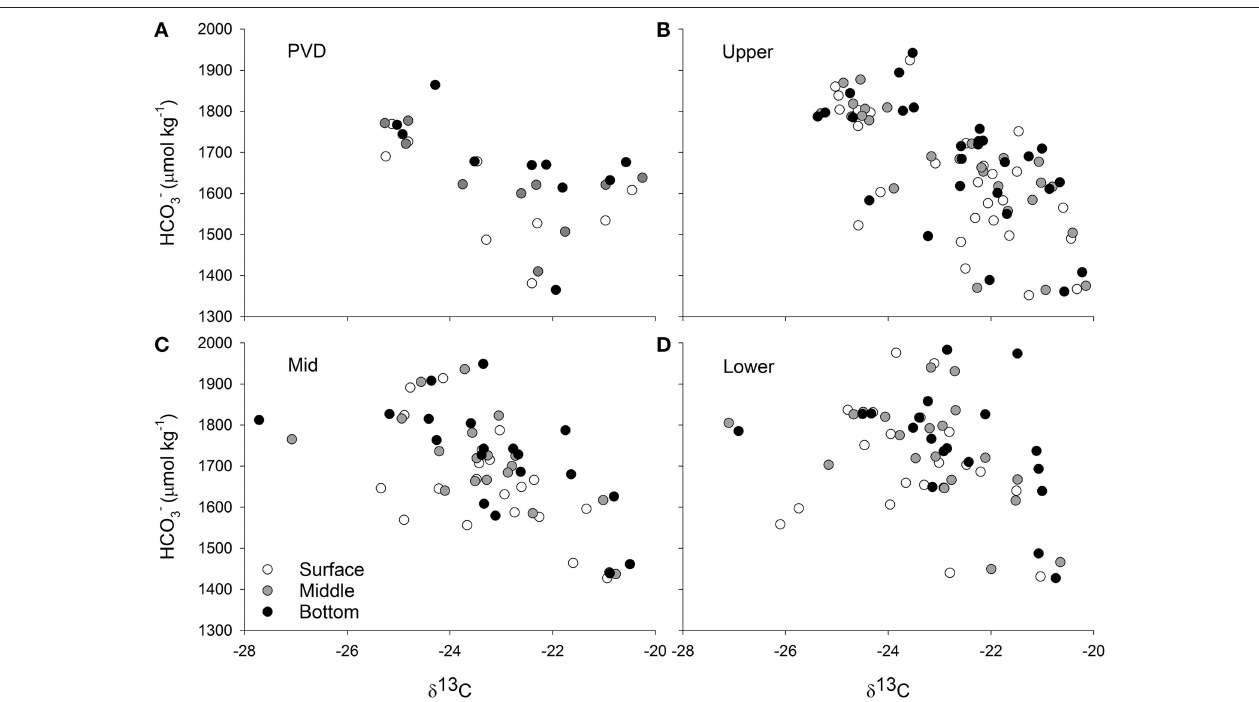
FIGURE 6 | Carbon stable isotope values measured on particulate matter collected from eight stations in Narragansett Bay ( Figure 2 ) and at three depths (surface, middle of the water column, and bottom) are plotted against bicarbonate concentrations at the same station and water column position. Stations are grouped by region where PVD is the Providence River Estuary (A) , Upper is the Upper Bay (B) , Mid is the Middle of Narragansett Bay (C) , and Lower is the Lower Bay (D) . The HCO − 3 concentrations were calculated from dissolved inorganic carbon and total alkalinity measurements of water samples and from temperature and salinity measurements made in the field. Methodological details are given in the text.